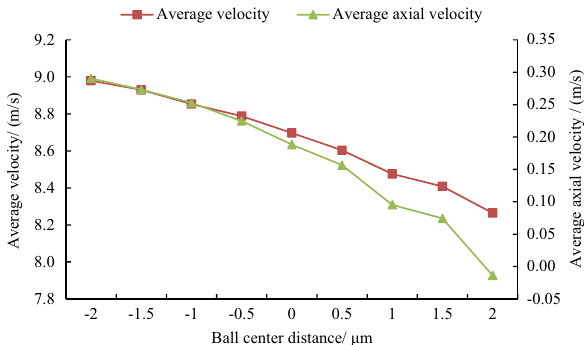
Figure 6. Gas velocity at different ball center